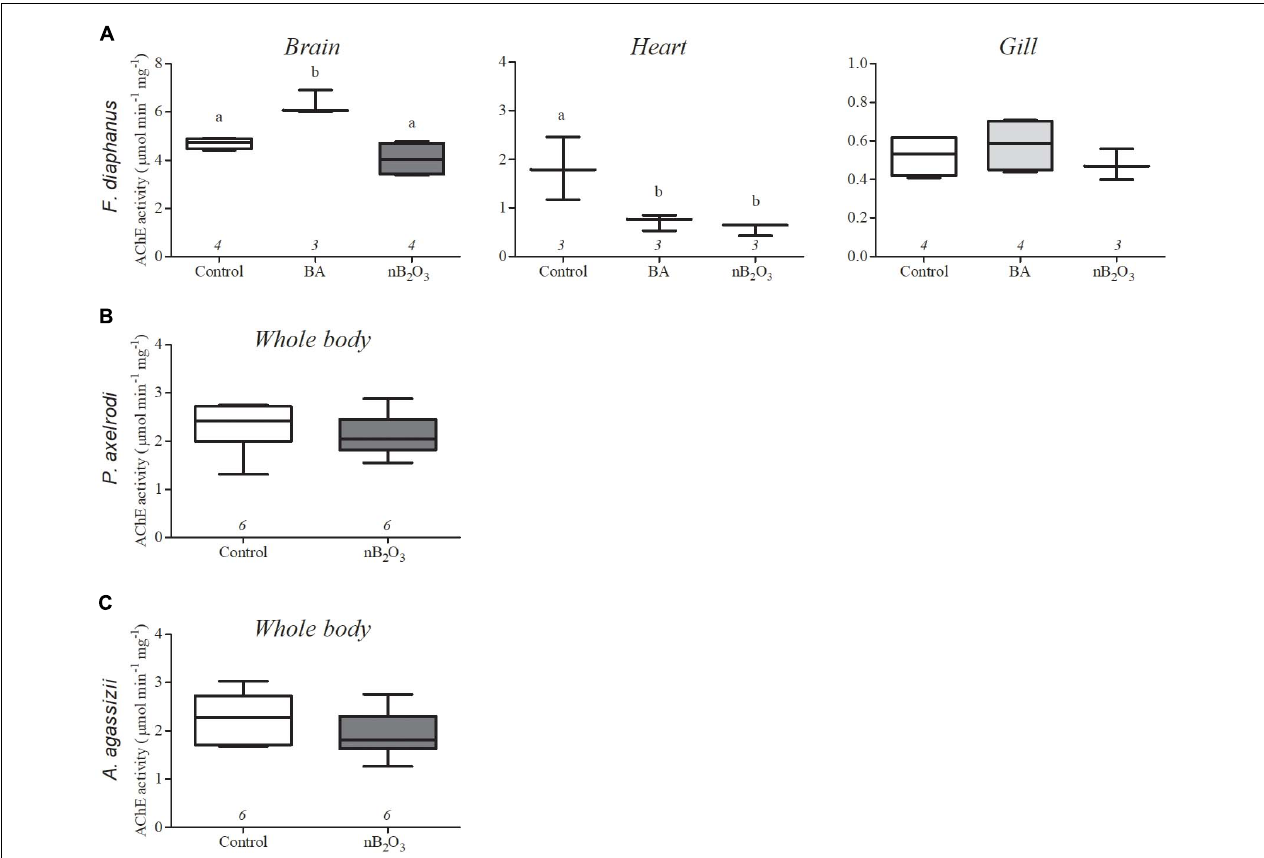
FIGURE 5 | Effects of BA (10 mg L − 1 ) and nB 2 O 3 [1.0 mg L − 1 for Fundulus diaphanus (A) , 10.0 mg L − 1 for Paracheirodon axelrodi (B) , and Apistogramma agassizii (C) ] exposure on tissue acetylcholinesterase (AChE) activity. Sample size is indicated beneath each plot and significant differences between treatment groups are denoted by dissimilar